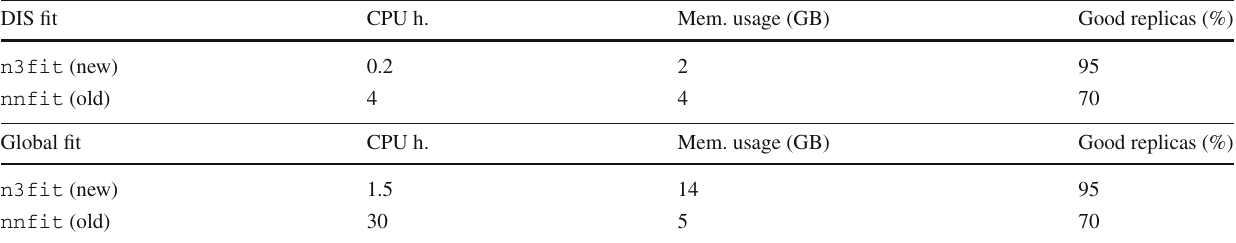
Table 1 Comparison of the average computing resources consumed by the old and new methodologies for the DIS and Global setups. We find n3fit to be ∼ 20 faster on average. The only drawback is the big-